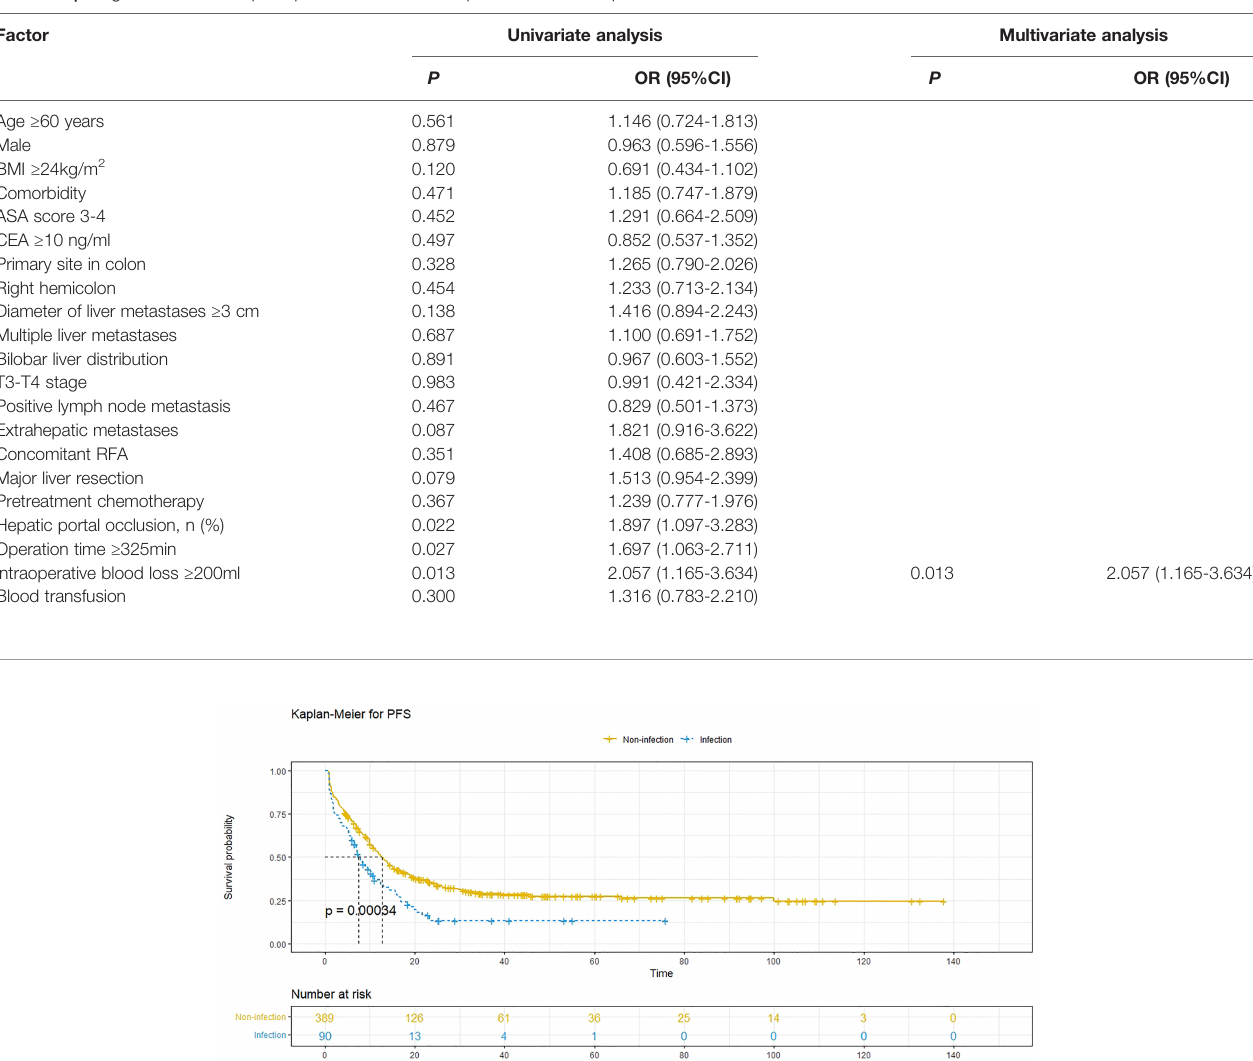
TABLE 3 | Prognostic factors for postoperative infectious complications in CRLM patients before PSM.